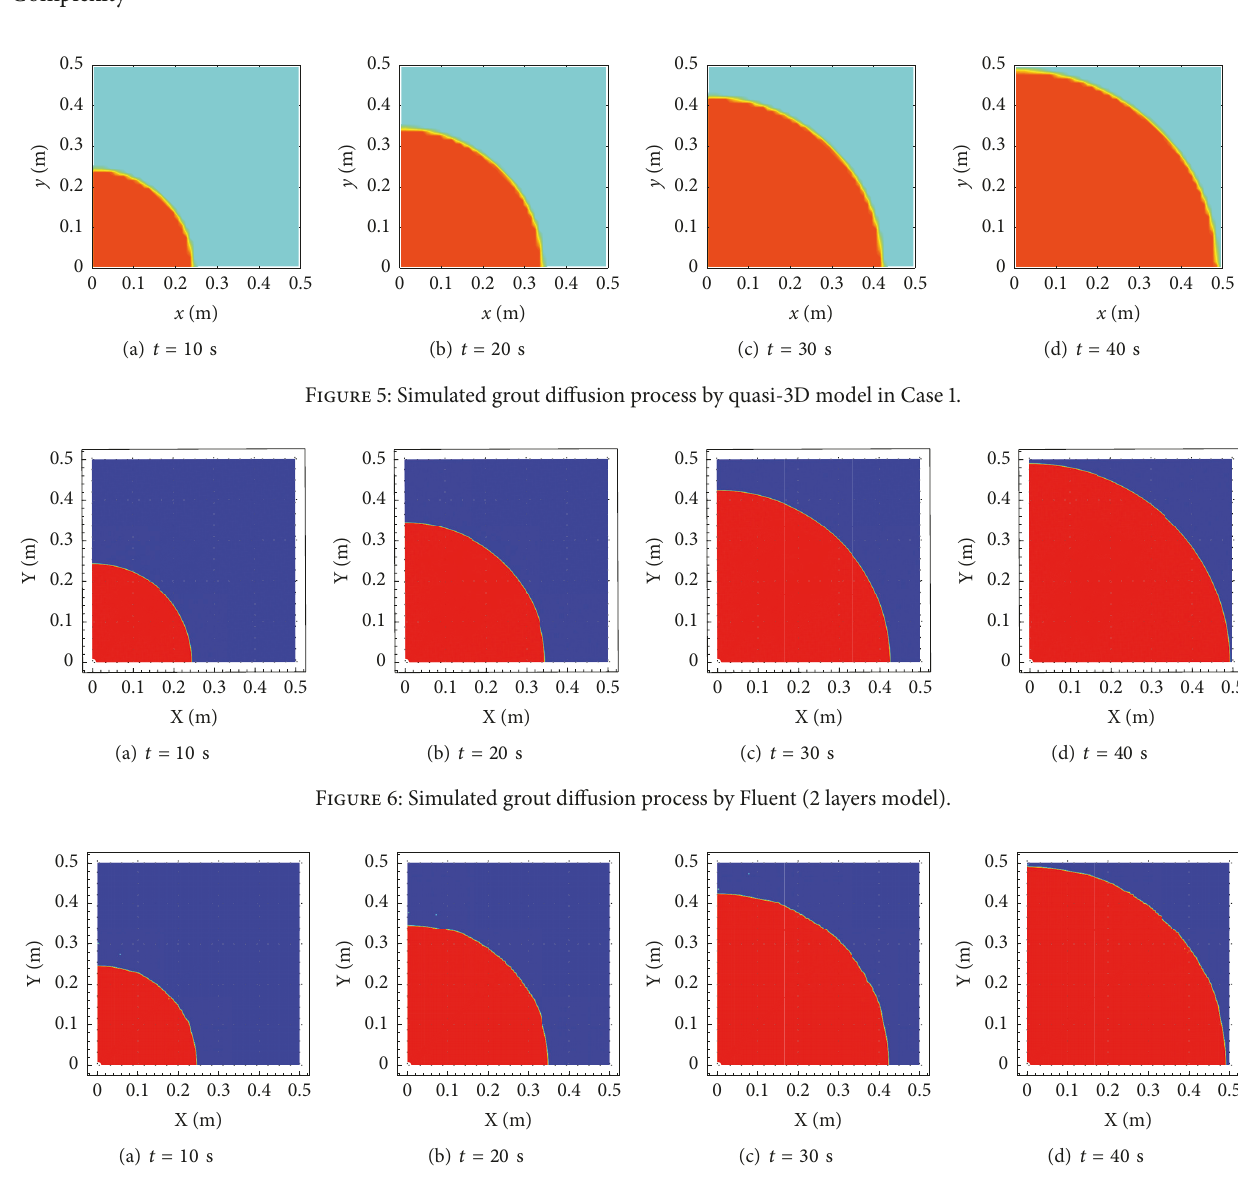
Figure 7: Simulated grout diffusion process by Fluent (6 layers model). Table 1: Variations of the diffusion radius with time calculated by three models in Case